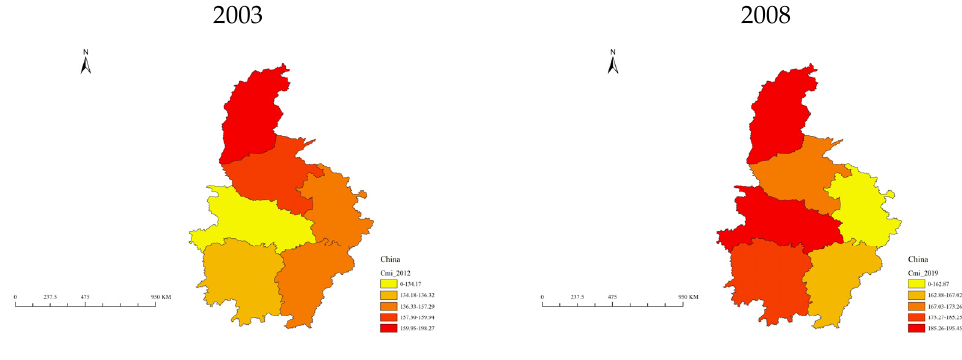
2019 Figure 4. The level of market integration in western China. In addition, after 2009, the market integration level in the northeast region signifi- cantly increased but sharply declined after 2016 in Figure 5. This may be because the pro- motion of the revitalization strategy of the northeast stimulated cooperation and exchange between regions to a certain extent. Still, due to the solidification of the industrial founda- tion and many difficulties in transformation, the industrial transformation may not be able